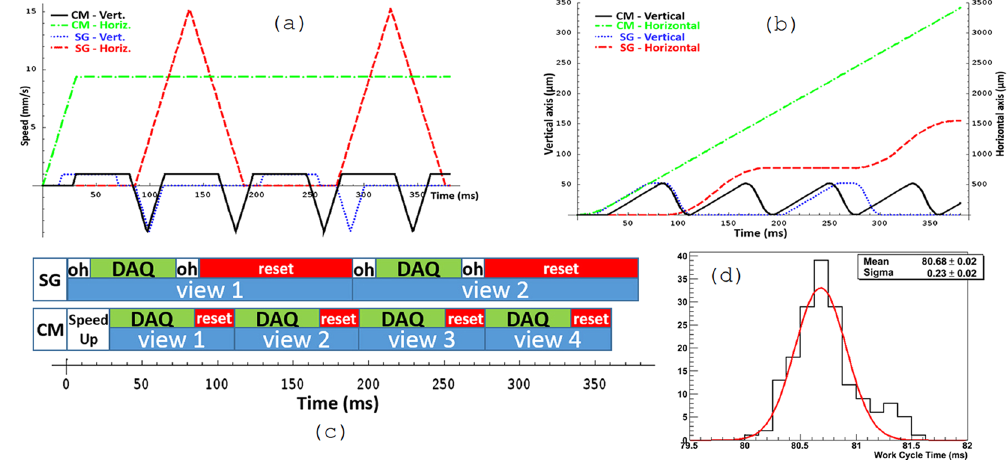
Figure 3. Speed ( a ) and displacement ( b ) profiles and scanning phase chart ( c ) for the SG and the CM techniques. The DAQ phase takes the same time in both techniques while the reset time is drastically reduced in the CM. The plot ( d ) shows the working cycle time distribution for the FPGA implementation of the CM.